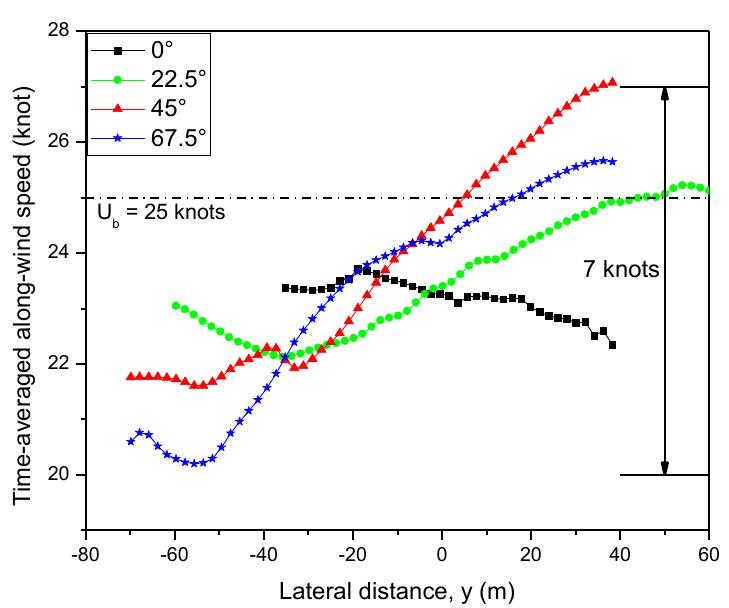
Figure 10. Changes of time-averaged along-wind speed lateral traverse at x ≈ 337.5 m. Background wind speed ( U b ) is set as 25 knots.